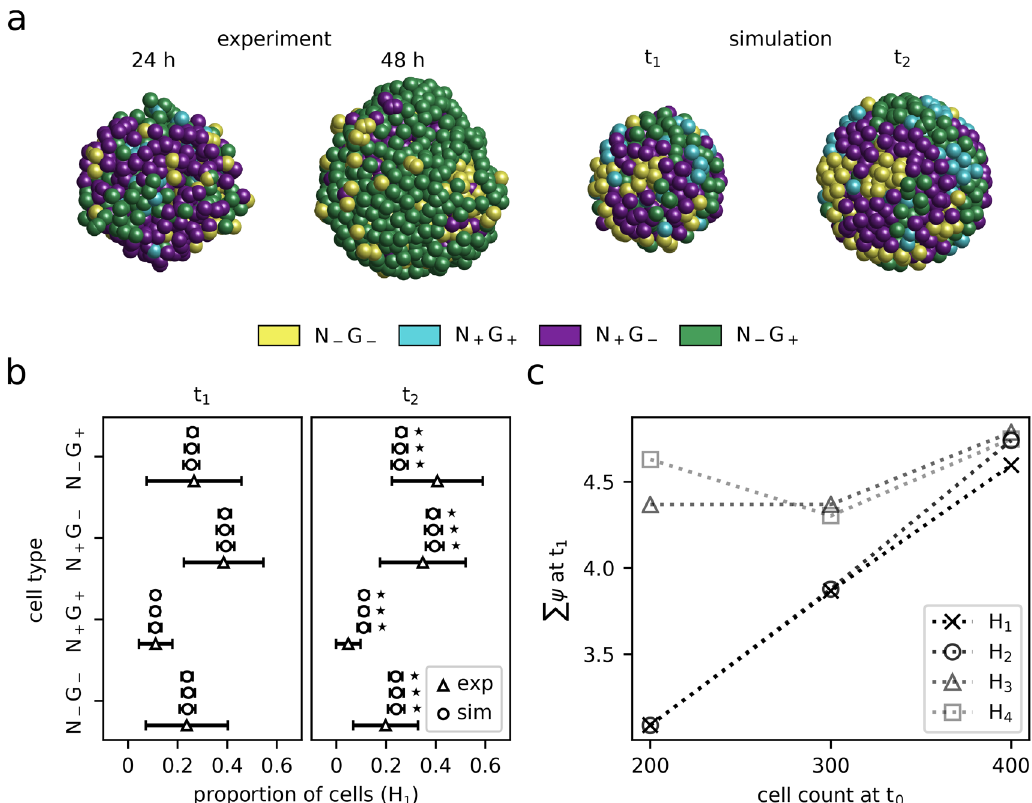
and ICM spheroids as percentage of the total number of cells within ICM organoids at t 1 and t 2 . Simulations were performed under the assumption H 1 . Experimental data from Mathew et al. are indicated by triangles. Simulation results for different t 0 are indicated by circles. The error bars indicate the standard deviation. t 0 from lowest line to top: 200, 300 and 400 cells. Statistically significant differences between the cell fate proportion of ICM organoids and ICM spheroids are indicated by stars ( p < 0.05 ; using a Wilcoxon–Mann–Whitney test with Bonferroni correction). ( c ) The effect size ( ψ ) as the relative deviation of the simulated and